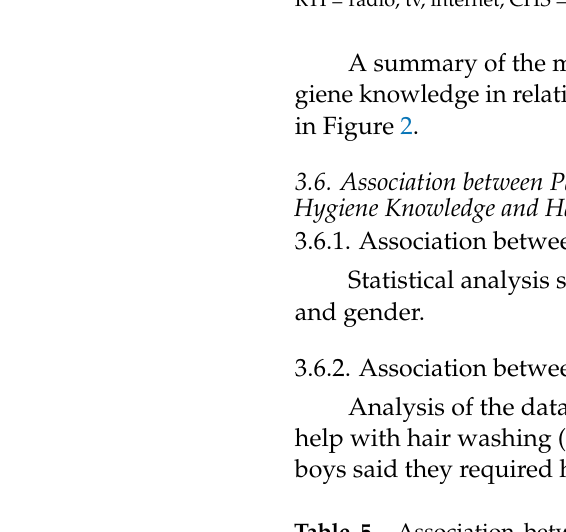
Table 5. Association between sociodemographic variables, autonomy, knowledge and habits, and